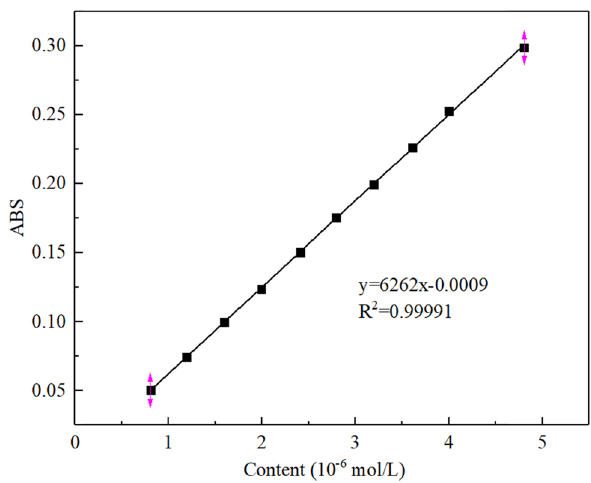
Figure 4: The concentration – absorbance linear adsorption fi tting curve of RH - β - CD.